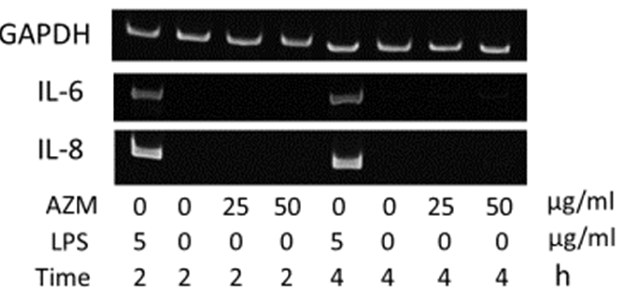
Figure 6. AZM alone does not enhance gene expression of IL-6 and IL-8 in hGFs.